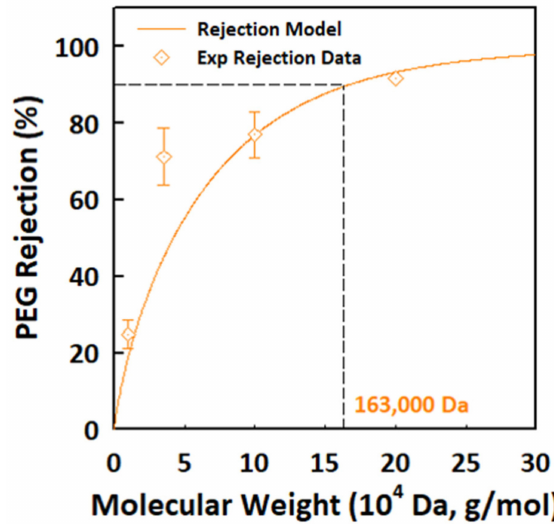
Figure 10. PEG retention of the α -Al 2 O 3 (1100 ◦ C) ultrafiltration membrane and the relationship between pore size and the molecular weight